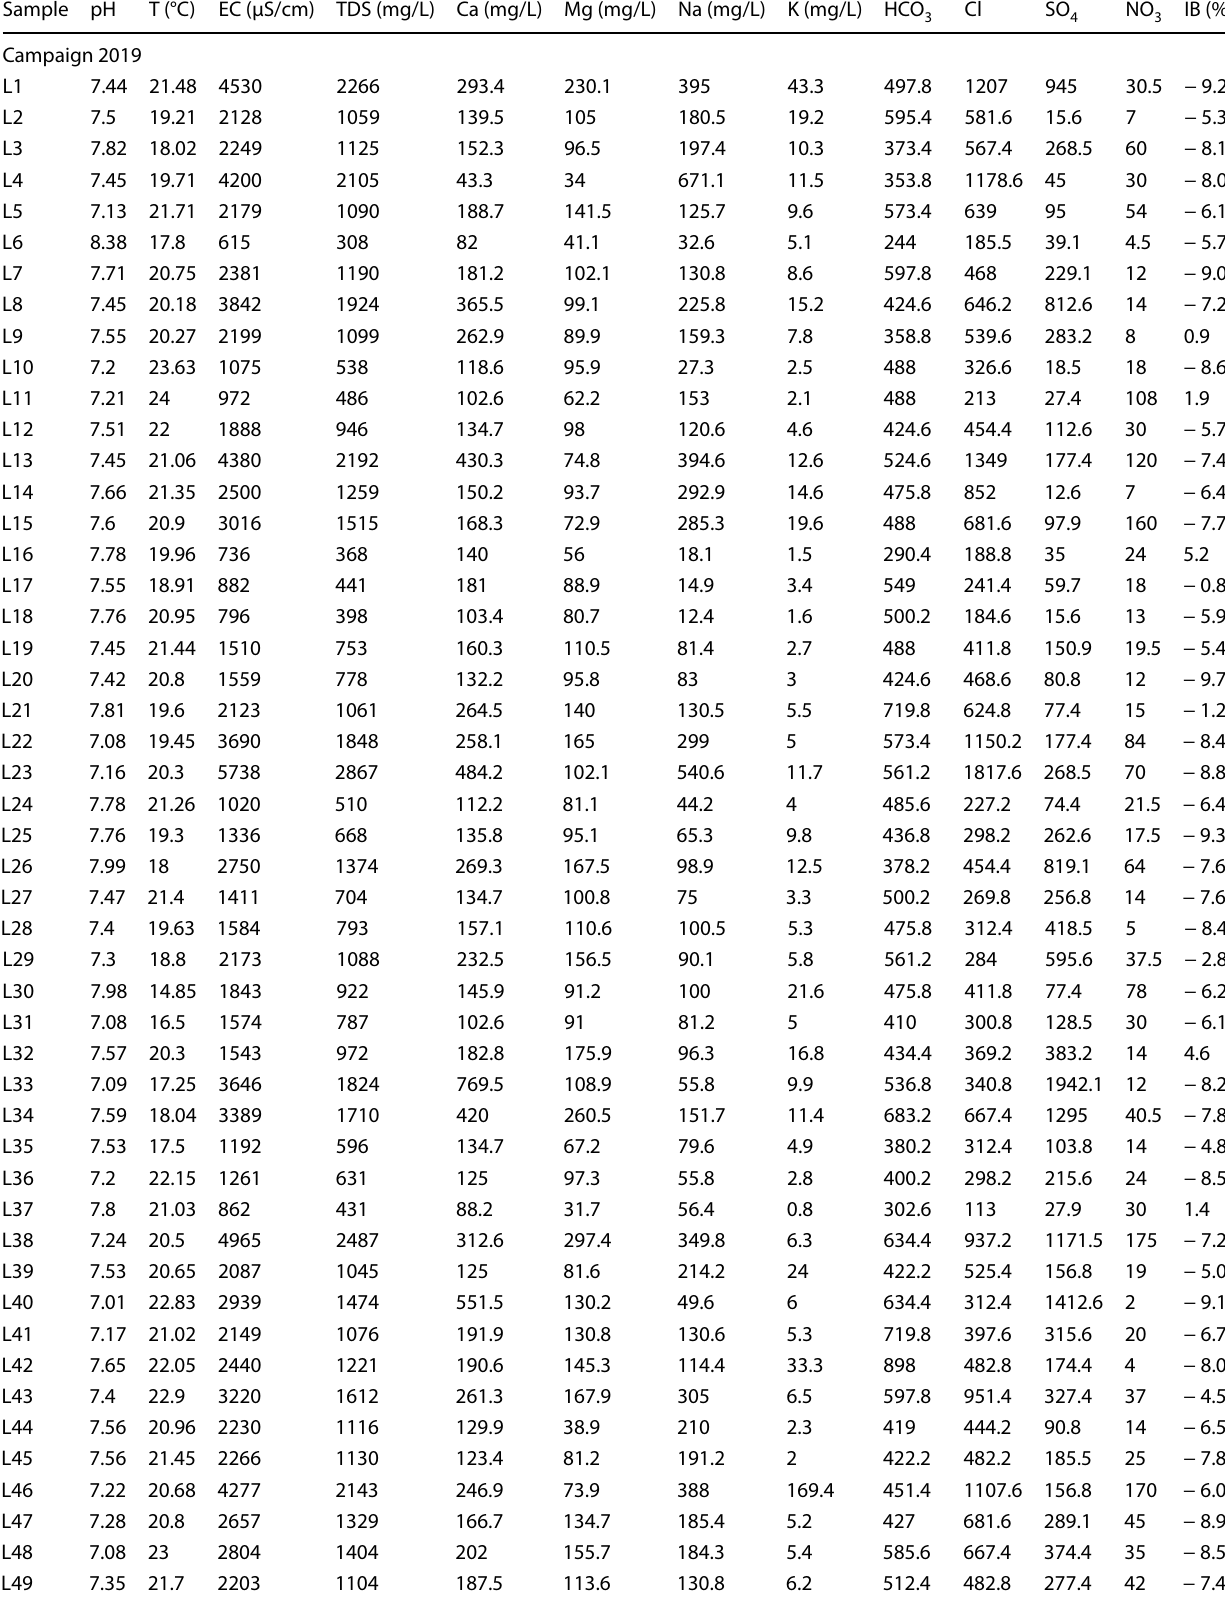
Table 2 Chemical composition of analysed samples of the campaign 2019 and 2020 Sample